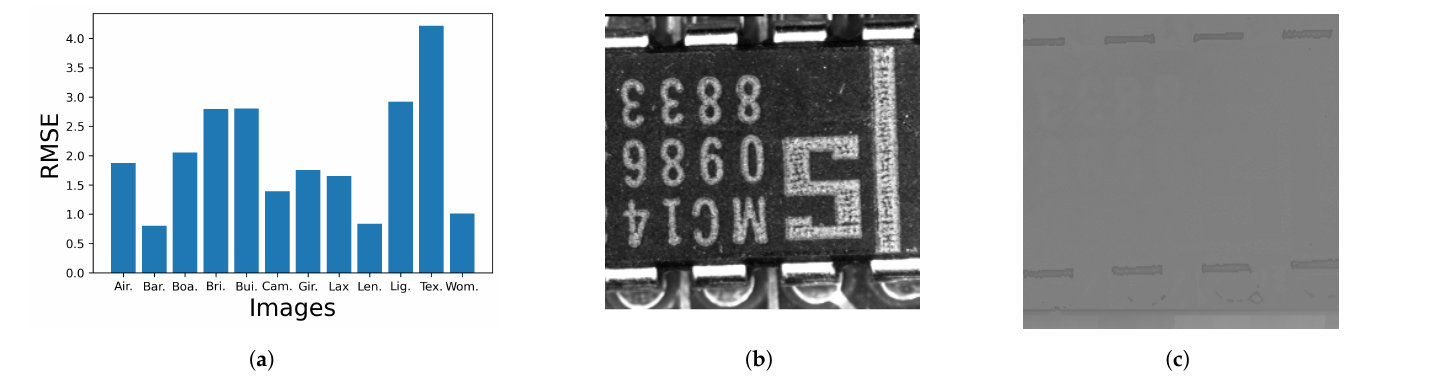
Figure 16. Comparison between Figures 14 and 15: ( a ) RMSEs of twelve grayscale images; ( b ) The “Text” image obtains the largest RMSE value in ( a ); ( c ) Difference from the neutral gray indicates the difference between Nikolova and Steidl’s and the proposed methods. ( a ) Root mean squared error; ( b ) Text (identical to Figure 13k); ( c ) Difference image.